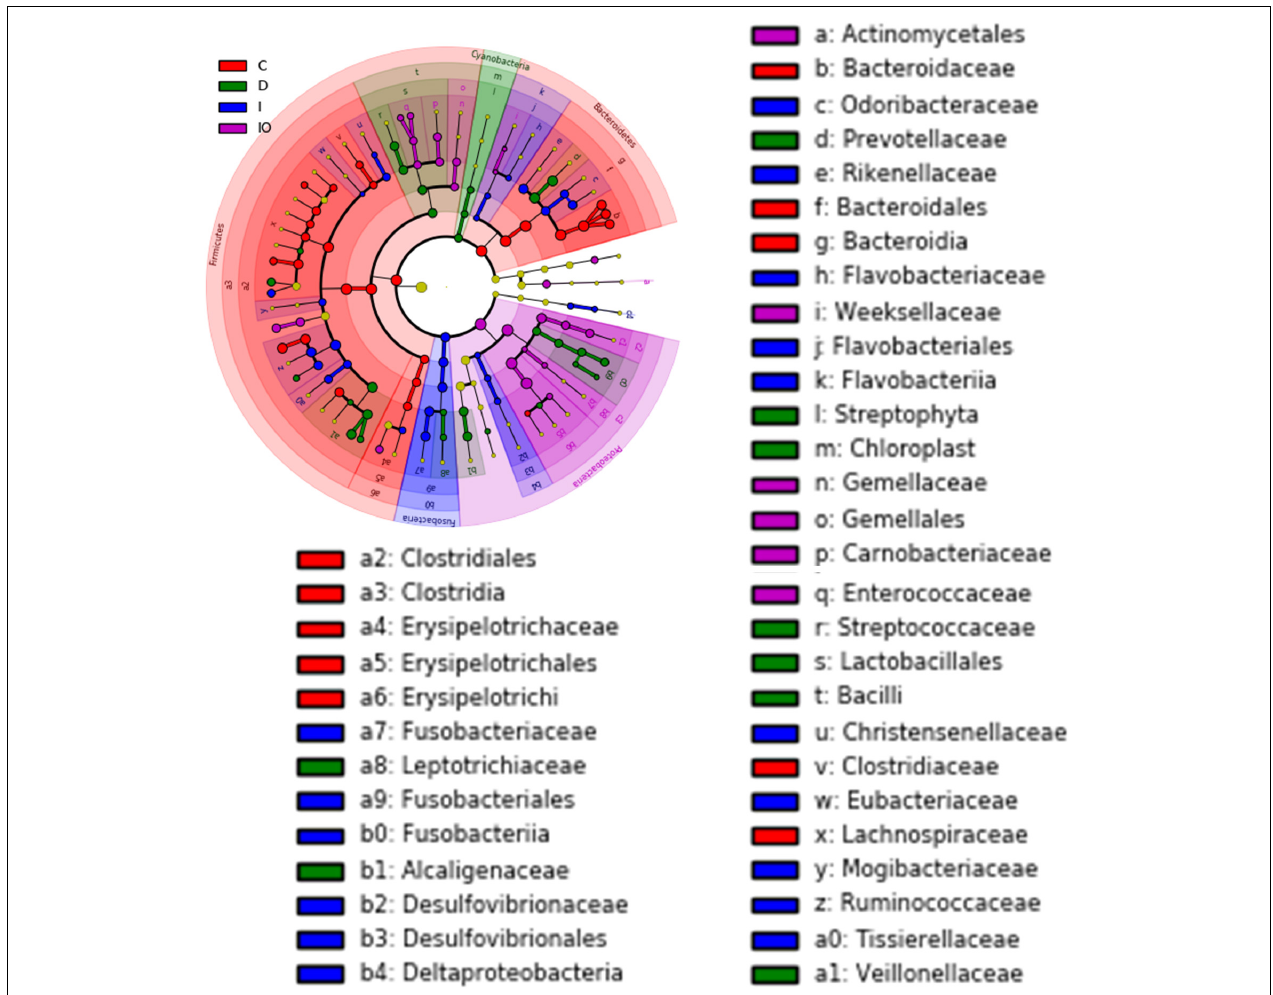
FIGURE 5 | Cladogram view of the representative microbial structure among the four groups. Phylogenetic view of the representative microbiota for each clinical group. Dominant microbial classes for the specific groups are represented by different colors. C, healthy individuals; D, CRC patients after chemotherapy; I, CRC patients before treatment; IO, CRC patients after surgical debulking. The diameter of each dot is proportional to the OTU